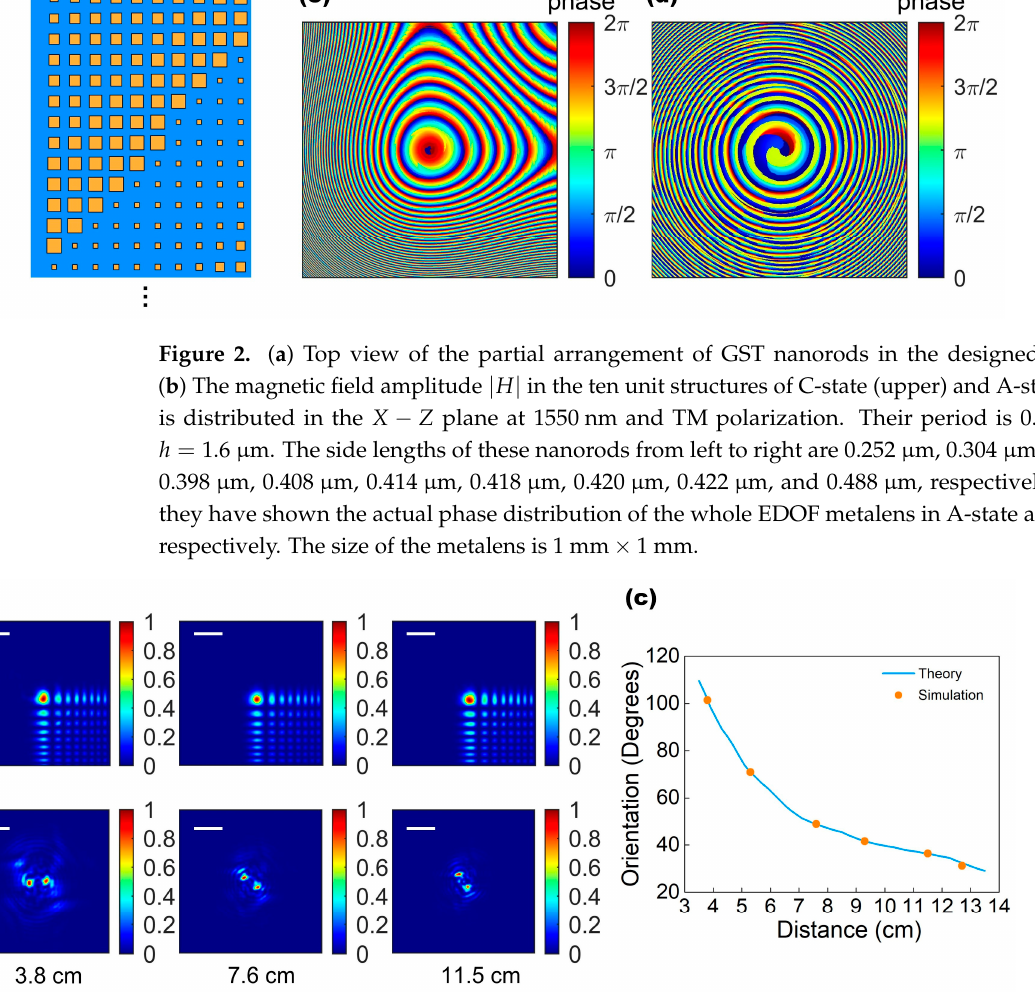
Figure 3. ( a ) The PSF generated by EDOF metalens at three different depths that are essentially unchanged with object depth. ( b ) The DH-PSF rotates around the center at three different depths. The depths in ( a , b ) are 3.8 cm,7.6 cm, and 11.5 cm . Scale bar: 64 μm . ( c ) The theoretical relationship curve between DH-PSF rotation angle and object distance (blue line); the simulated results of rotation angle of DH-PSF varied with the object distance (orange points).